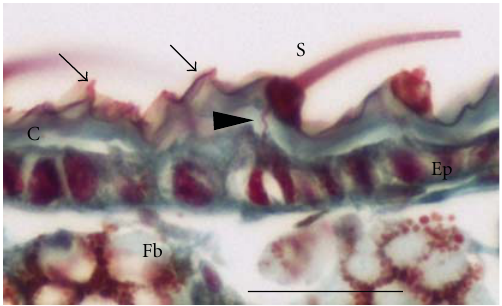
Figure 22: Detail of gland cell with vacuoles (V) in the cytoplasm and granules (arrows) in both the cytoplasm and the lumen. Scale bar = 30 μ